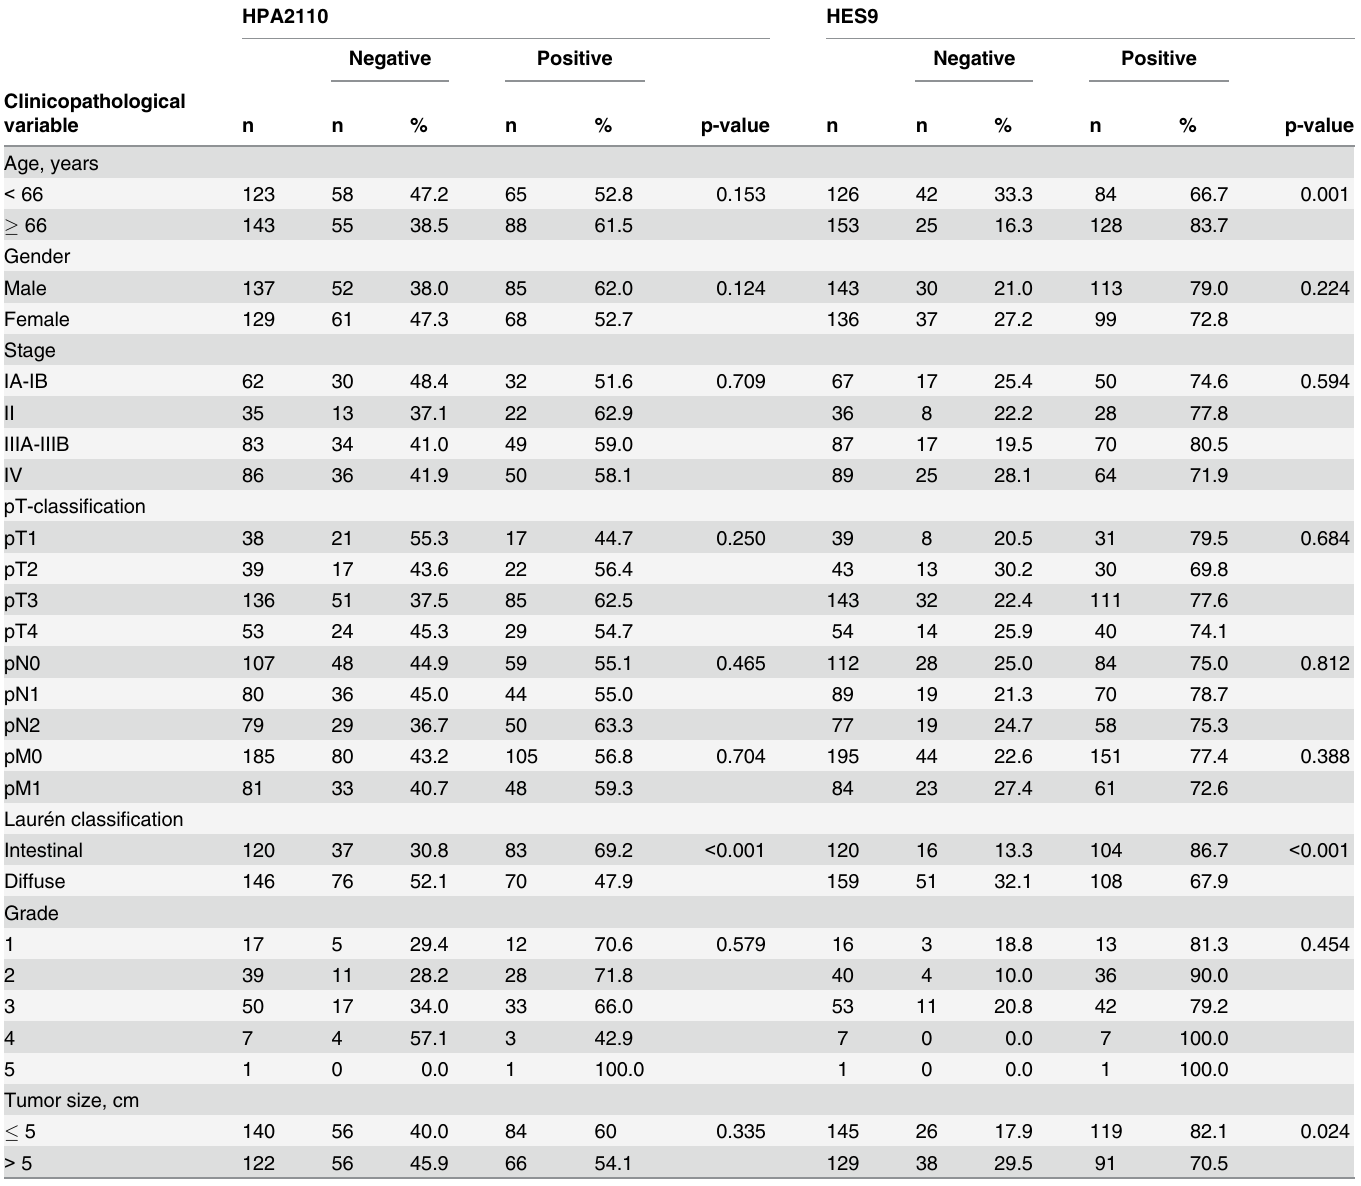
Table 1. Association of HPA2110 and HES9 with clinicopathological variables in gastric cancer patients. HPA2110 HES9